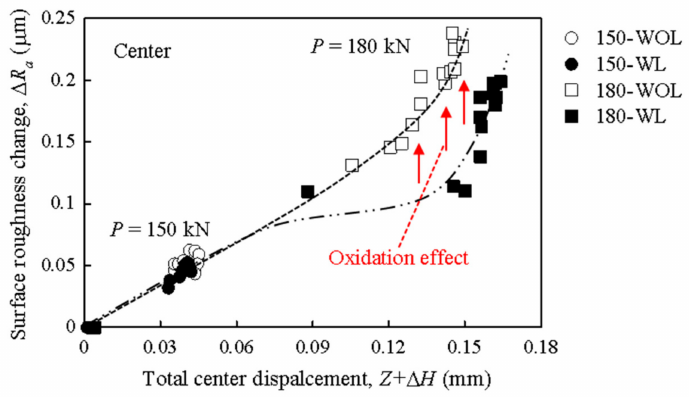
Figure 17. Relationship between the surface roughness change and total center displacement. (150 / 180—Forging load (kN), WL—With Lubrication, WOL—Without Lubrication).